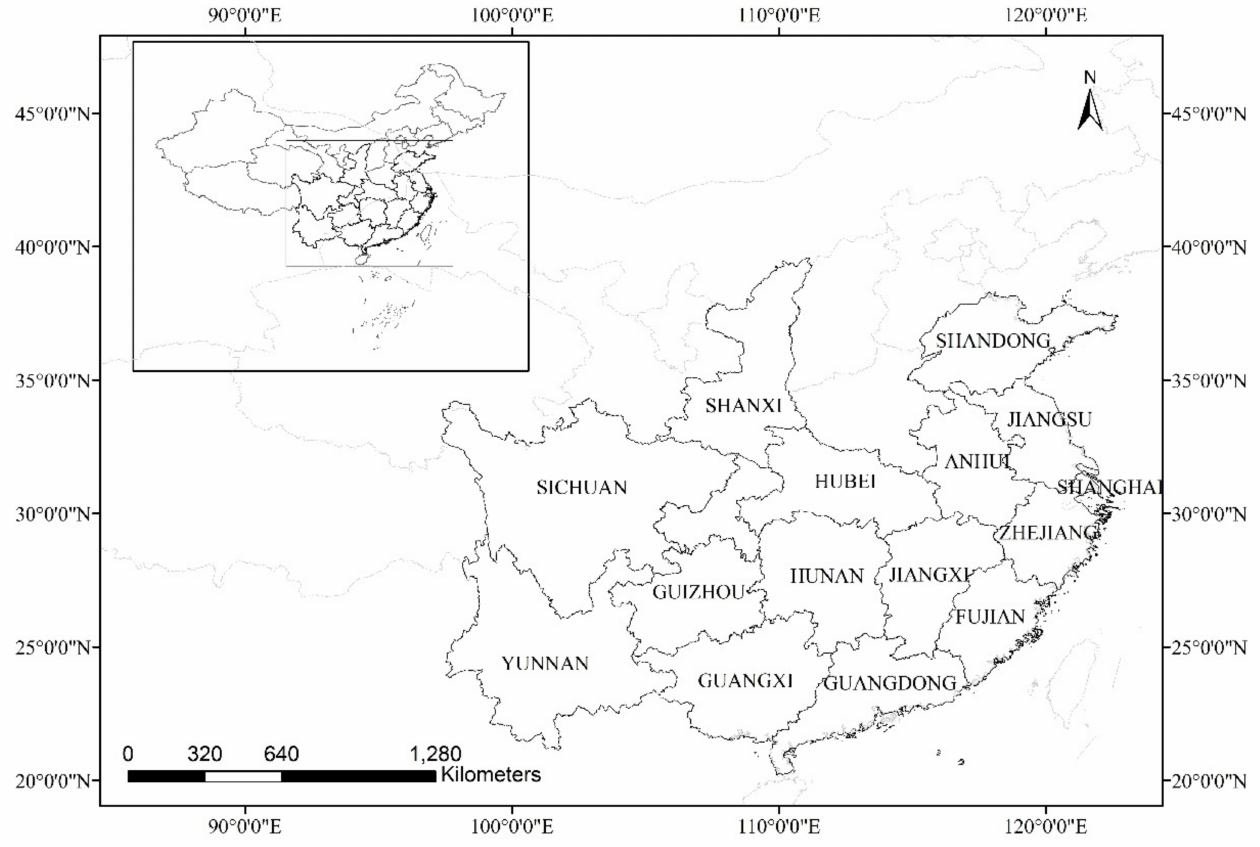
Figure 1. Provinces and municipalities surveyed in